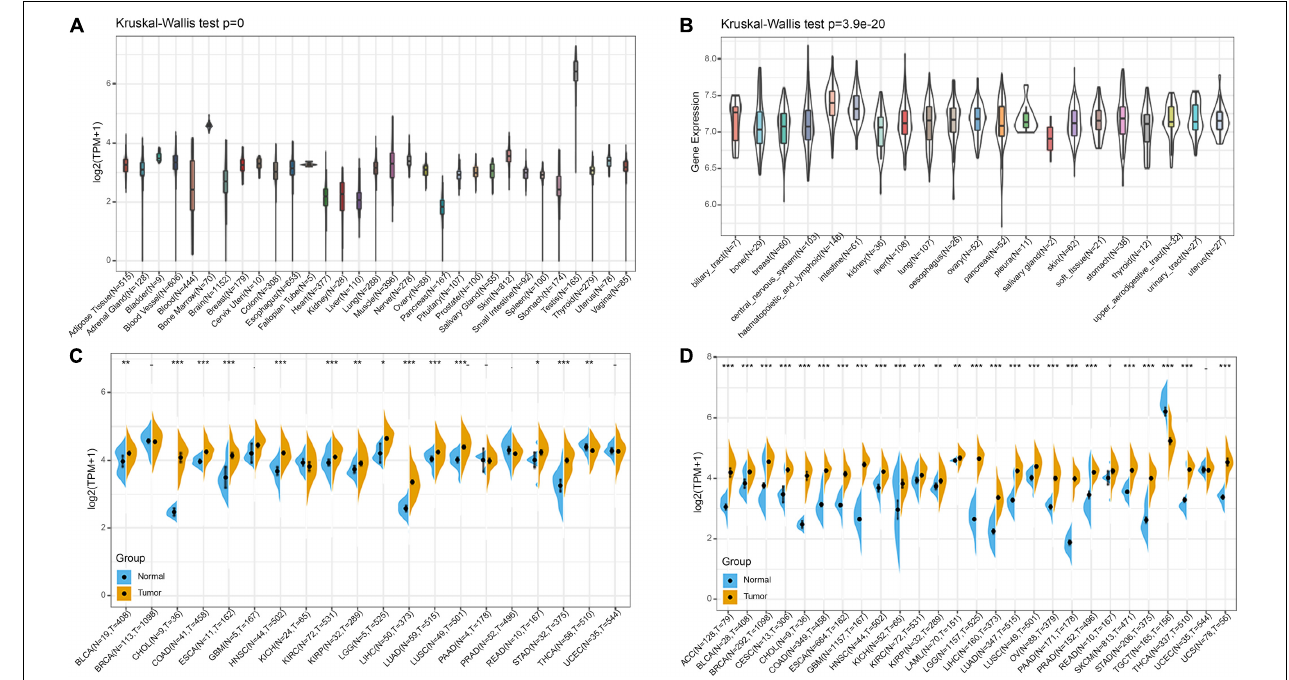
FIGURE 1 | BRAP is abnormally expressed in human pan-cancer. (A) BRAP expression in 31 tissues from the GTEx database. (B) BRAP expression in 21 tumor cells from the CCLE database. (C) Differential expression of BRAP in cancers and normal tissues from TCGA database. (D) BRAP is abnormally overexpressed in 25 cancer types from the GTEx database and TCGA database (* P < 0.05, ** P < 0.01, *** P <